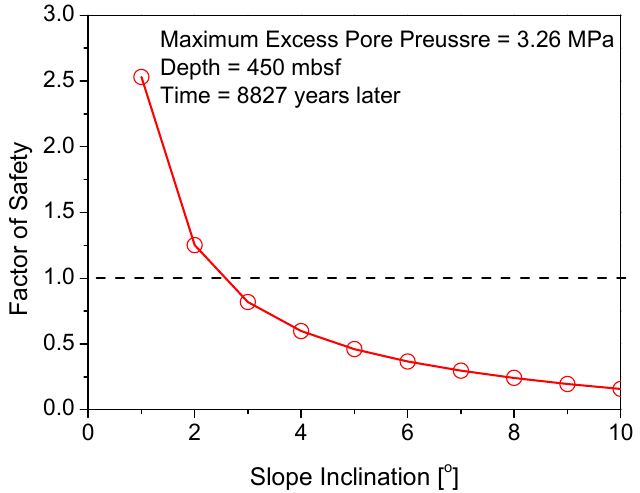
Figure 9. Factor of safety of an infinite hydrate-bearing slope with varying